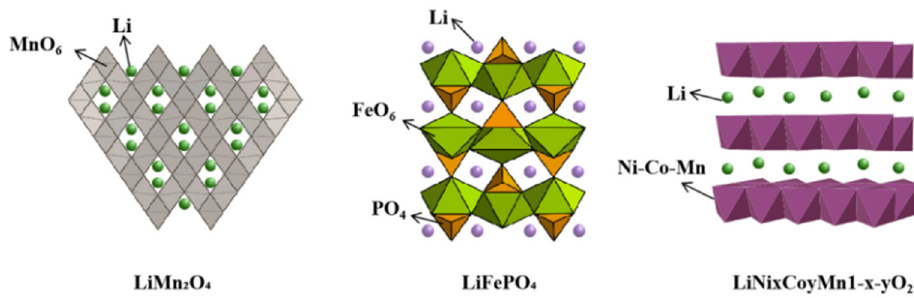
Figure 3. Three kinds of working electrodes for electrochemical extraction of Li.